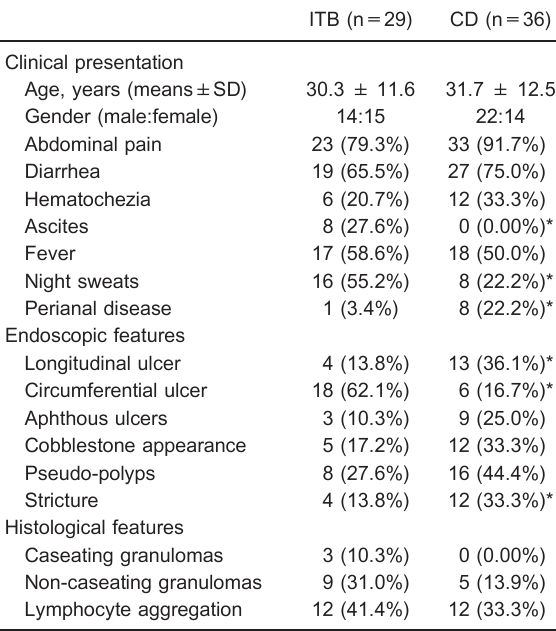
Table 1. The differentiating clinical, endoscopic, and histological features of patients with intestinal tuberculosis (ITB) and Crohn’s disease